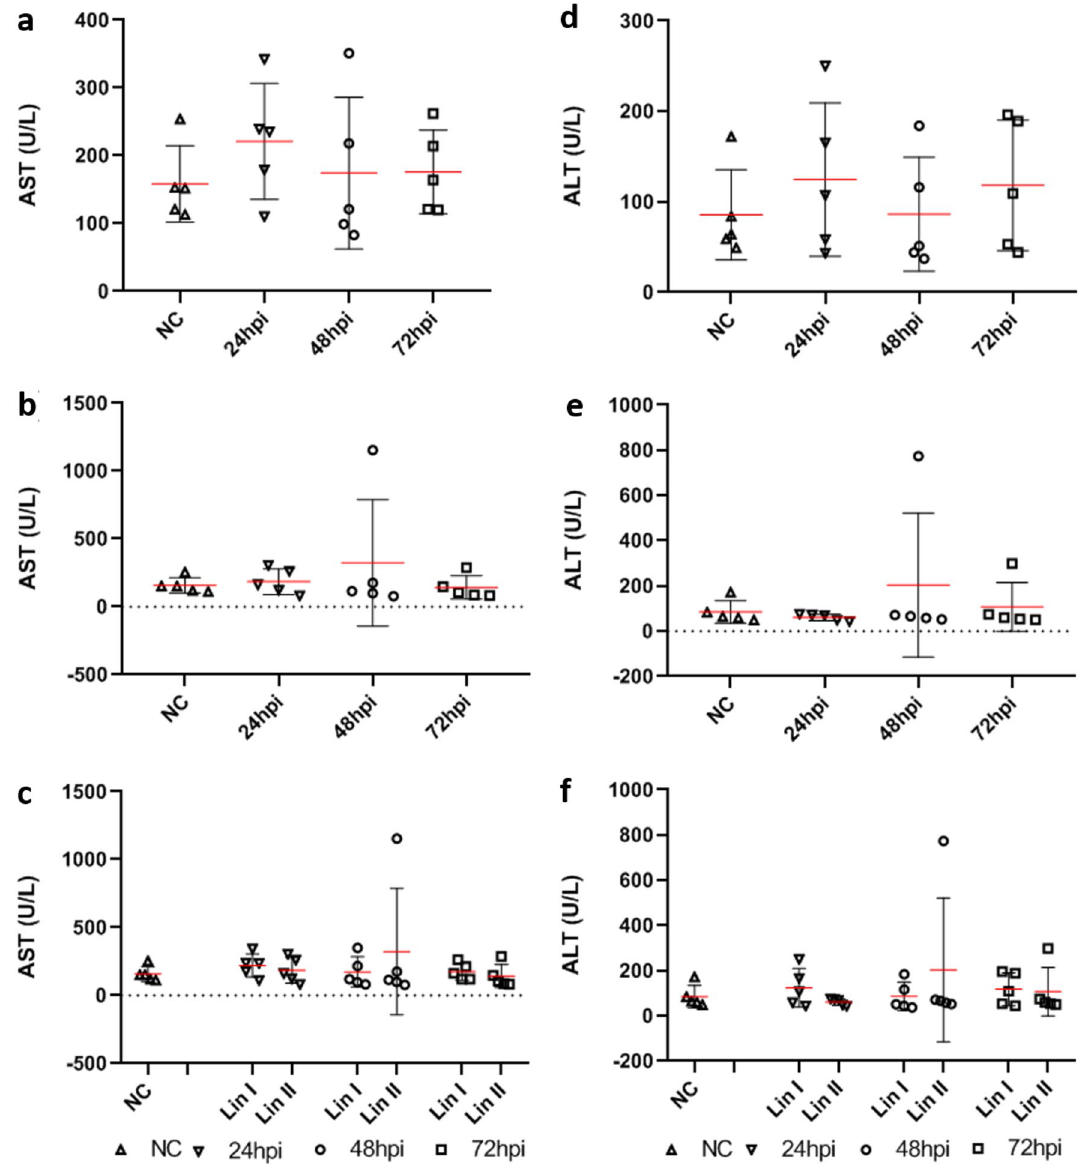
Figure 5. Transaminases levels (U/L) of BALB/c mice uninfected and infected with DENV-2 Lineages 24, 48 and 72 hpi. AST: ( a ) DENV-2 Lineage I; ( b ) DENV-2 Lineage II; ( c ) comparison of AST levels means. ALT: ( d ) DENV-2 Lineage I; ( e ) DENV-2 Lineage II; ( f ) comparison of ALT levels means. NC: (n = 5); Lin I: (n: 24 hpi = 5; 48 hpi = 5; 72 hpi = 5); Lin II: (n: 24 hpi = 5; 48 hpi = 5; 72 hpi = 5). NC: negative control, n: number of mice, hpi: hours